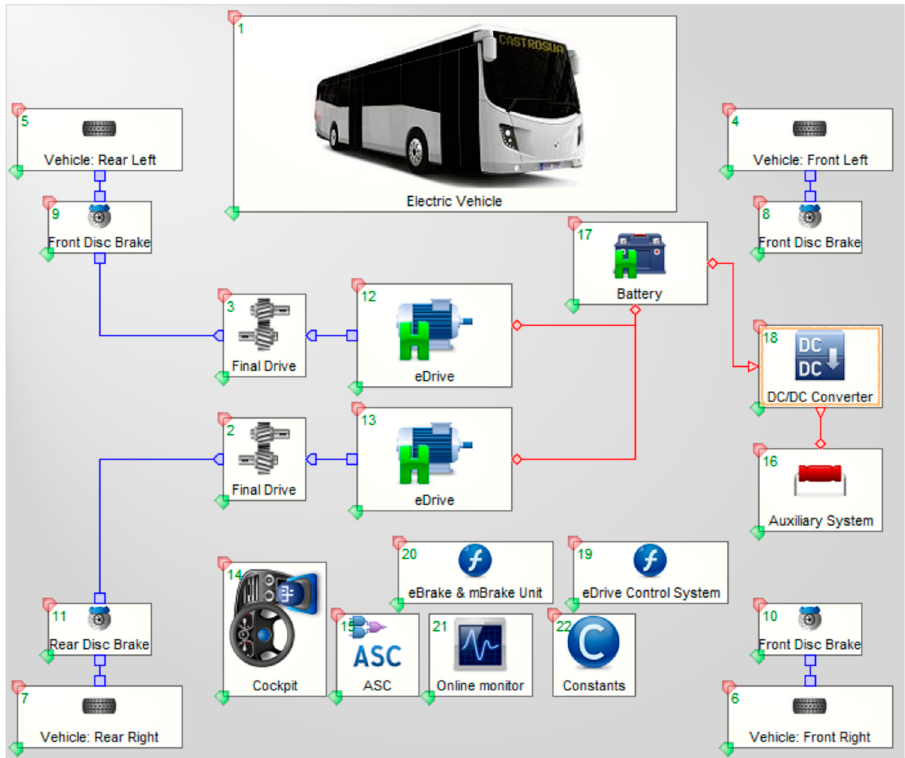
Figure 9. Electric urban bus model.